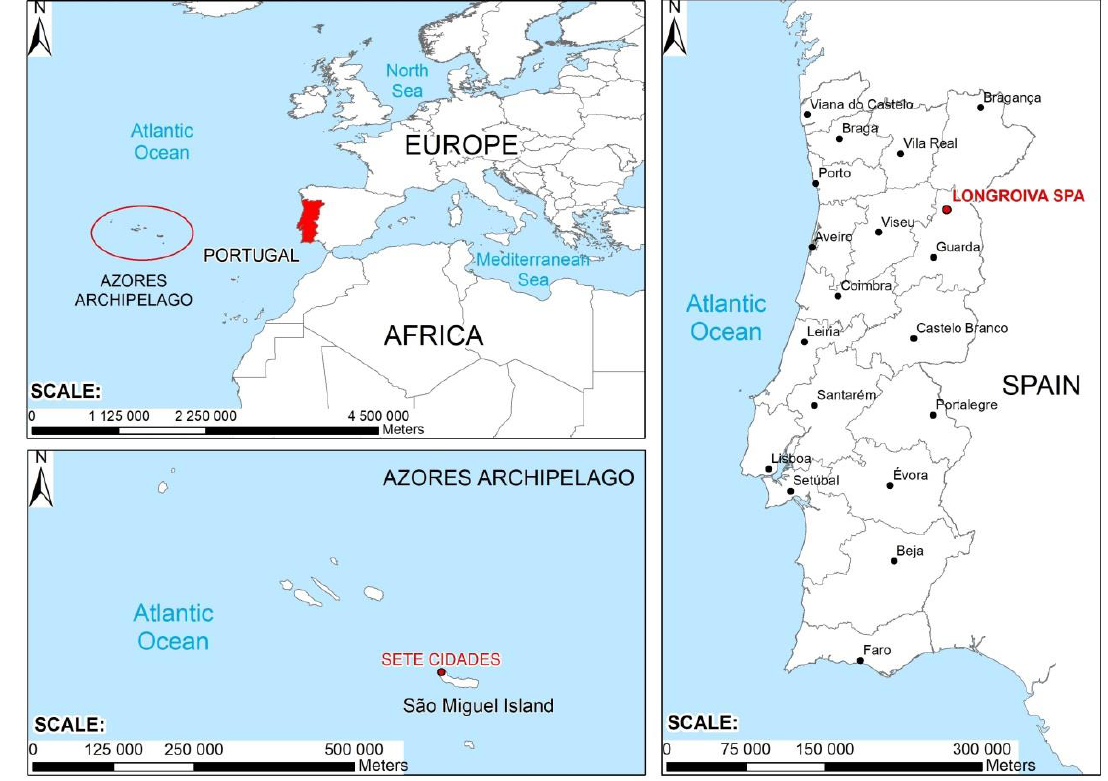
Figure 1. Location of the two investigated sites. Sete Cidades, Azores, Portugal, active volcanic zone; Longroiva Spa, Portugal, granitic craton associated to a regional active fault. Adapted from Portuguese Directorate-General of the Territory (DGT) maps database http://www.dgterritorio.pt/. Reproduced with permission from [13]. Portuguese Directorate-General of the Territory, 2019.